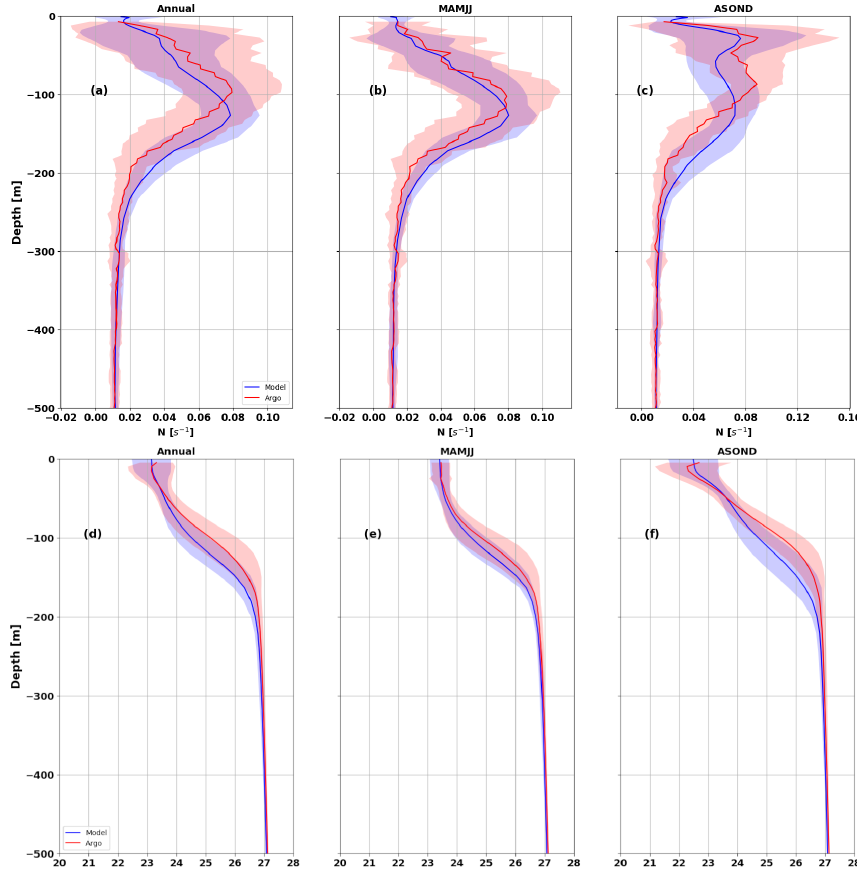
Figure 4. Mean vertical profiles from Argo (red) and model (blue) during (a, d) March to December 2015 (annual) and (b, e) MAMJJ and (c, f) ASOND. (a–c) Brunt–Väisälä frequency ( N , units: s − 1 ). (d–f) Potential density (units: kgm − 3 ). The blue and red envelopes are the standard deviation. See Fig. 1 for Argo profile location. Model profiles are collocated in time and space with Argo